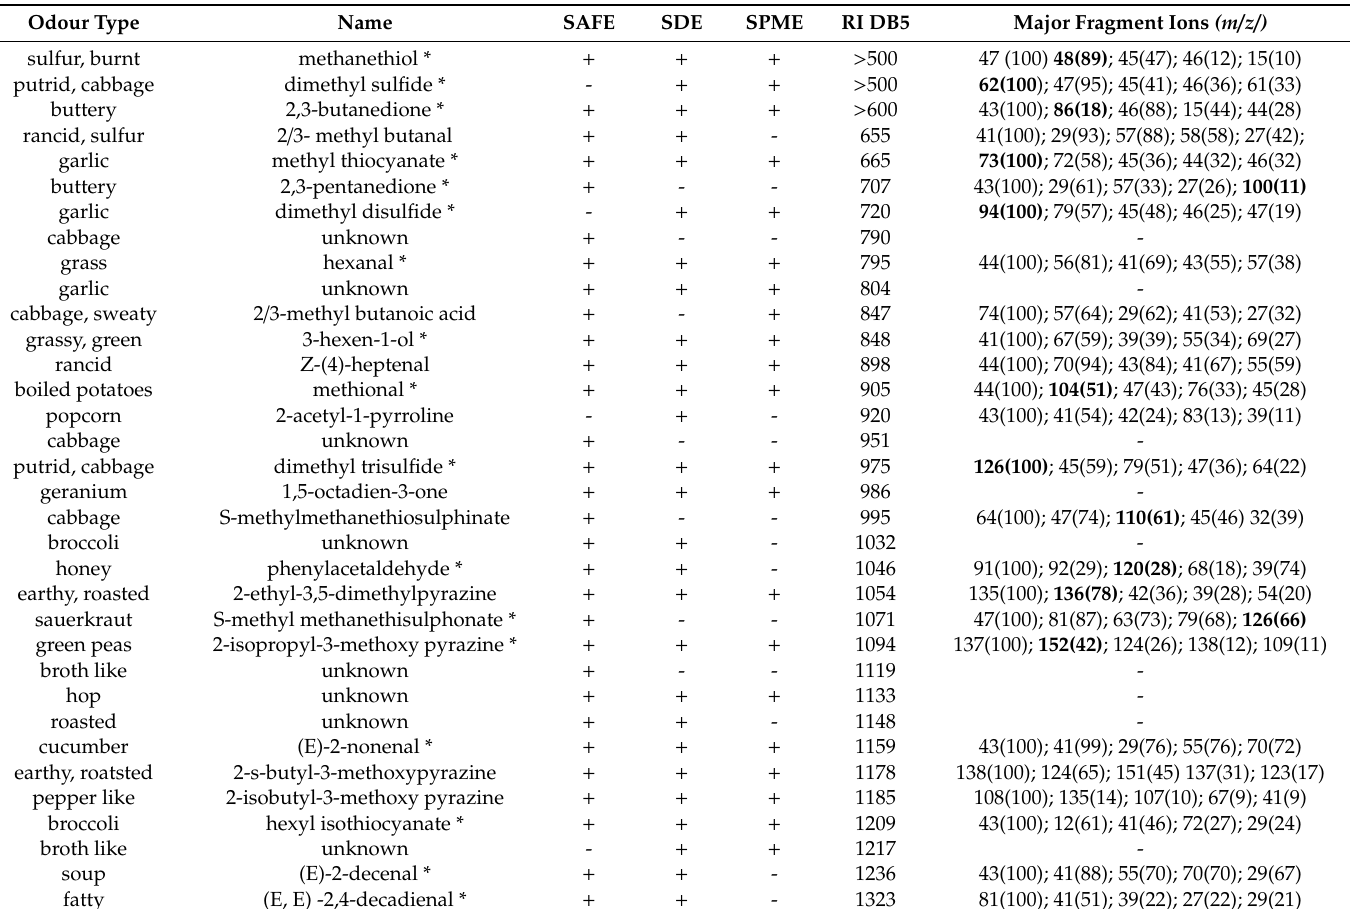
Table 1. Compounds identified using gas chromatography-olfactmetry (GC-O) and gas chromatography-mass spectrometry (GC-MS) in raw broccoli after extraction using three methods: solvent-assisted flavor evaporation (SAFE), simultaneous distillation / extraction SDE) and solid-phase microextraction (SPME). *—identity confirmed with authentic standard